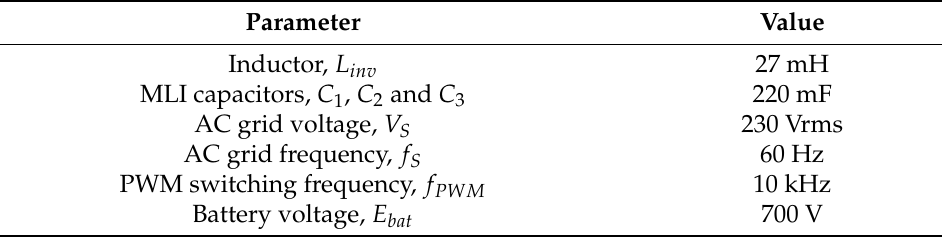
Table 4. Values of the simulation parameters.